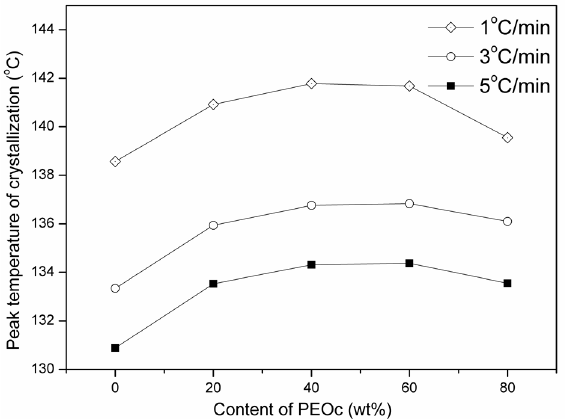
Figure 8. Peak temperatures of crystallization for the LCB PP/PEOc blends as a function of PEOc content at various cooling rates.